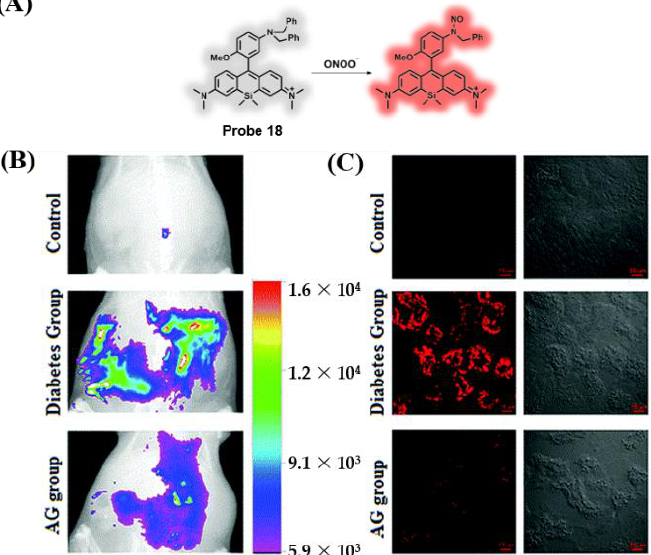
Figure 14. ( A ) Imaging mechanism of probe 18 ; ( B ) images of ONOO − in the peritoneal cavity of rats and ( C ) Confocal images of rat kidney in different groups after probe 18 (2 µ M, 0.2 mL per 100 g) injection, respectively, λ ex = 633 nm. Adapted from Reference [92]. Copyright 2018, the Royal Society of Chemistry.